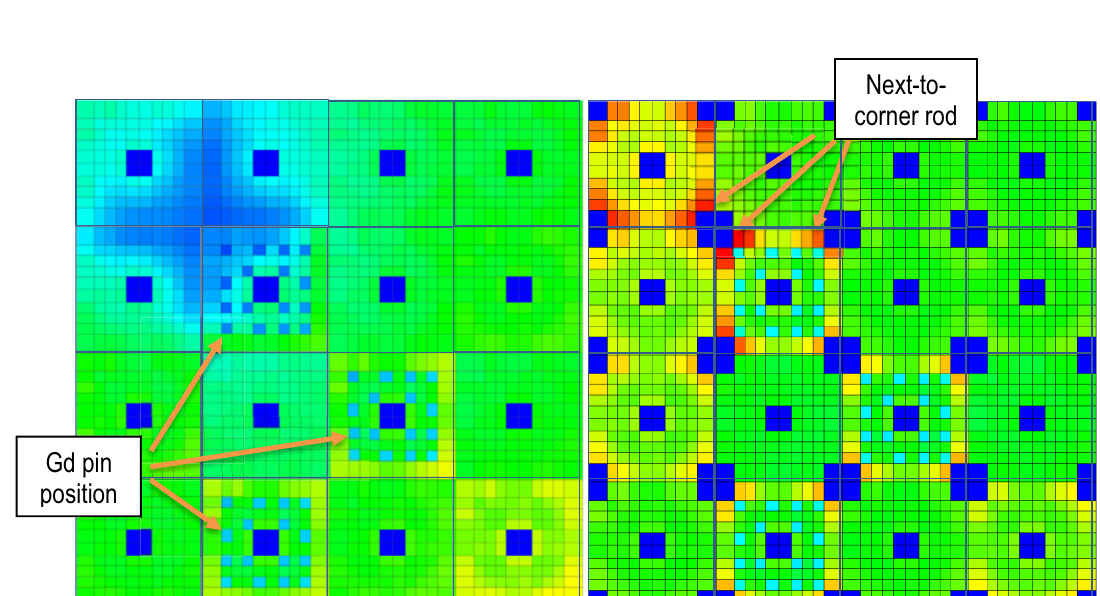
Figure 7. Steady-state TORT-TD/CTF pin power distributions in the 4-by-4 mini core model at axial posi- tions 70.4 cm (left) and 146.75 cm (right). (blue: low, green: medium, red: high)